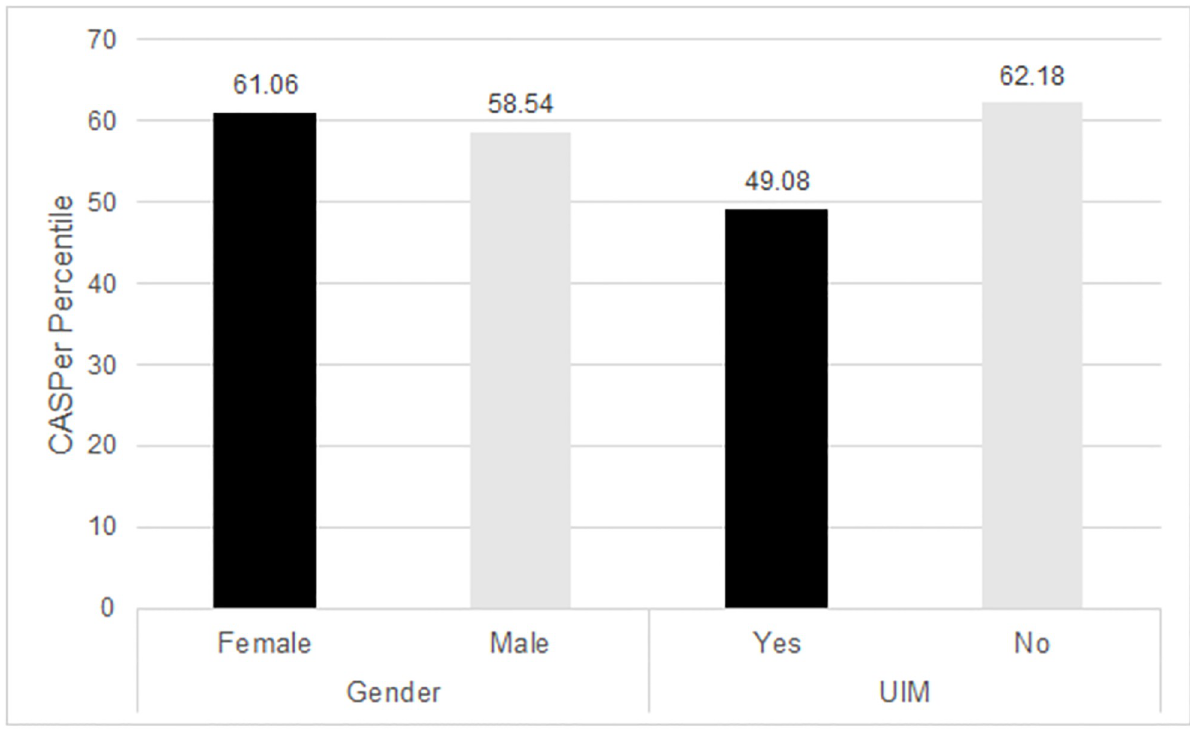
Fig 1. Differences in CASPer Percentile by Gender, SES Indicator, and UIM Status. A between subjects ANOVA indicated there were significant differences between CASPer percentile scores by each variable (Gender: F 2,1116 = 12.42, p < .001, h 2 = 0, UIM: F 2,1116 = 12.42, p < .001, h 2 = .02). Interactions between variables did not result in statistically significant